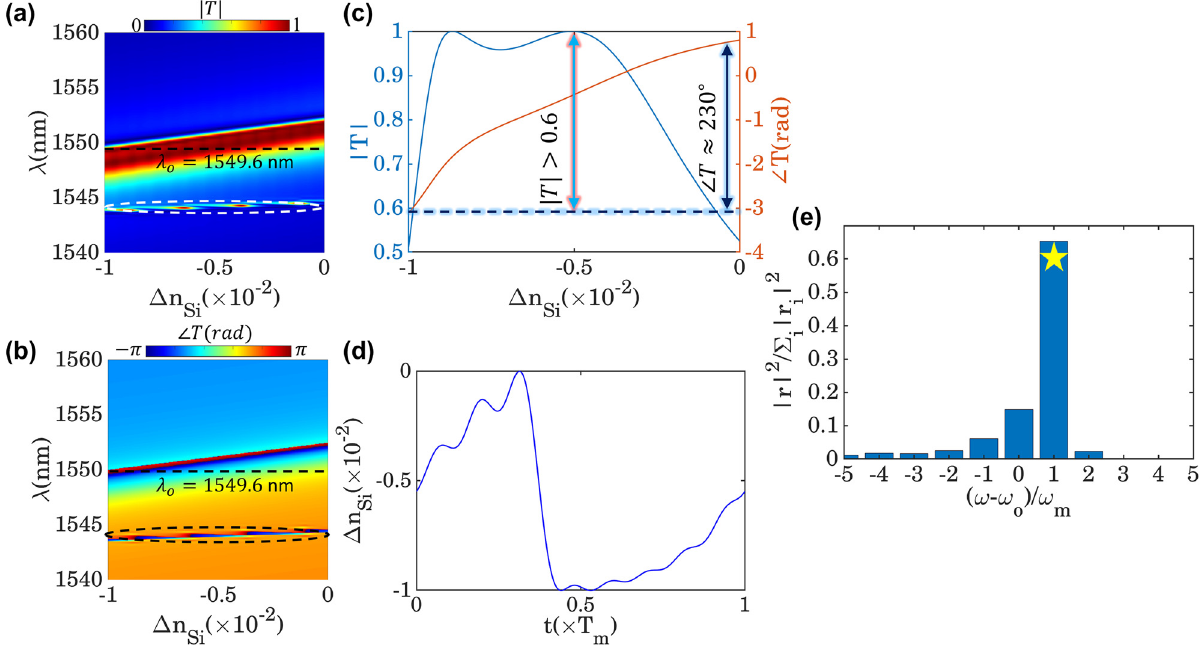
Figure 4: The active and time-modulated response of the second layer metasurface. The calculated transmission (a) amplitude and (b) phase of the temporal layer with respect to the operating wavelength and silicon refractive index change. Since the presented design is capable of supporting two types of resonances, its tunable response can also function in dual-bands around 𝜆 shown with black dashed lines. (c) The optical response of the same metasurface at the operating wavelength of 𝜆 exhibits high transmission amplitude above 60% and phase modulation of ≈ 230 ◦ . (d) The applied temporal waveform to the metasurface such that it can redirect the fundamental tone to the first up modulated higher-order harmonics. (e) The calculated output spectrum of the temporal metasurface. It is evident that the designed metasurface is competent in converting the fundamental harmonic to the first up modulated harmonic with a high conversion efficiency of | t +